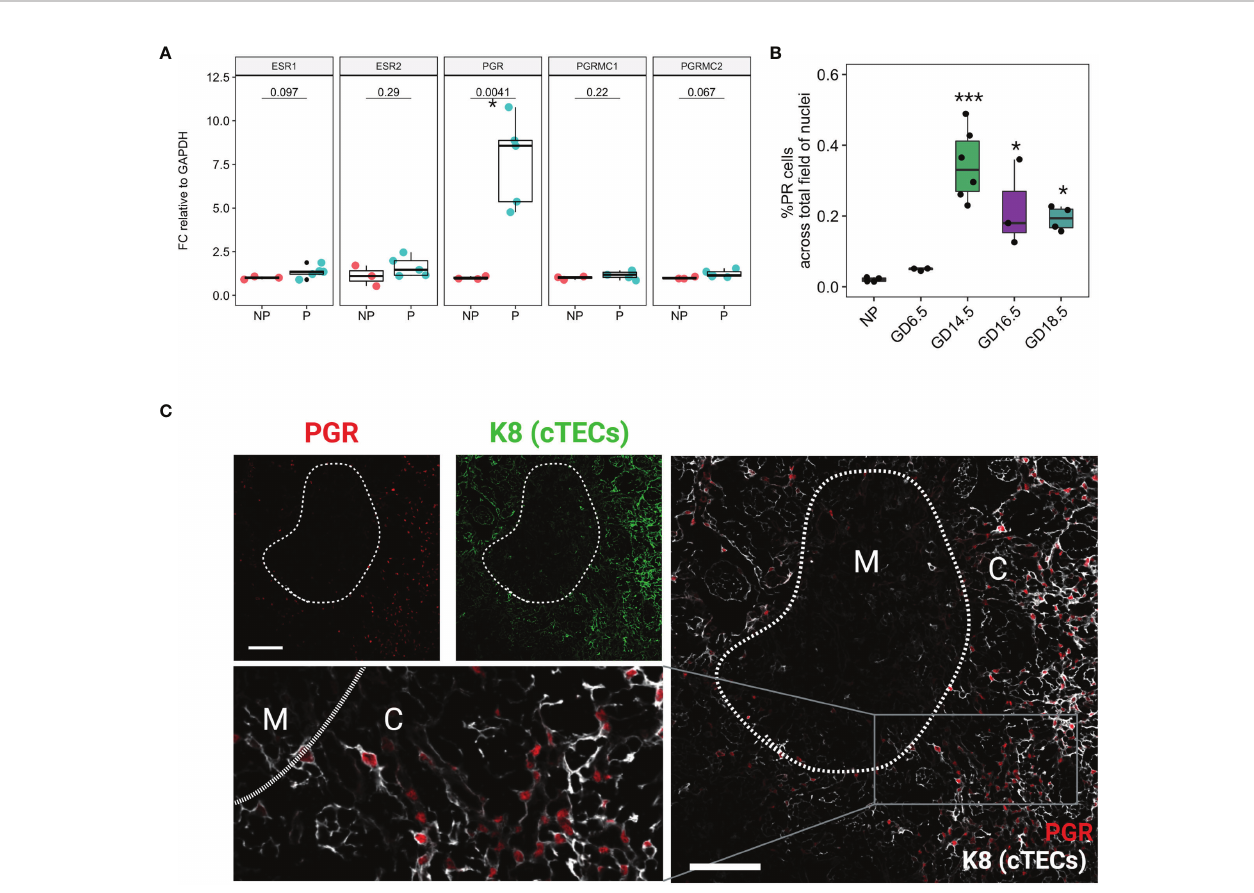
FIGURE 2 | Nuclear Progesterone Receptor expression increases in the thymus in pregnancy. (A) RT-qPCR for Esr1, Esr2, Pgr, Pgrmc1 , and Pgrmc2 between NP (n=3) and P (GD16.5, n=5) thymus. Each dot represents one mouse. (B) % PR positive nuclei calculated from fi eld of DAPI from NP (n=4), GD6.5 (n=3), GD14.5 (n=6), GD16.5 (n=3), and GD18.5 (n=4) thymus; see Supplementary Figure 1 for representative images. *p < 0.05, ***p < 0.0001; one-way ANOVA with Dunnett ’ s post-hoc test with comparisons to NP controls. Each dot represents one mouse. (C) Immuno fl uorescence staining of GD14.5 thymus with antibodies speci fi c to cytokeratin 8 (K8) and nuclear PGR. C, cortex; M, medulla, Scale bar = 100 m m, 200x magni fi